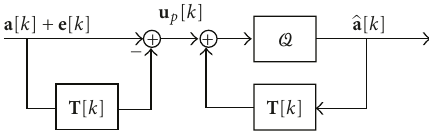
Figure 2: Structure of MIMO DFE